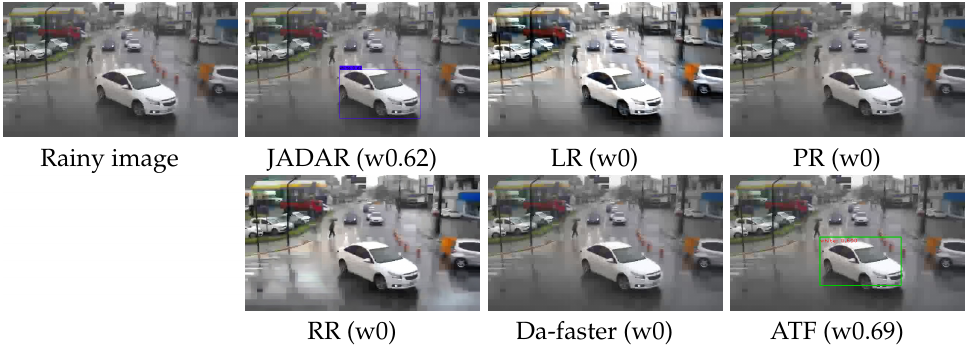
Figure 14. Test results of JADAR and two-stage and domain-adaptation methods on the RIS